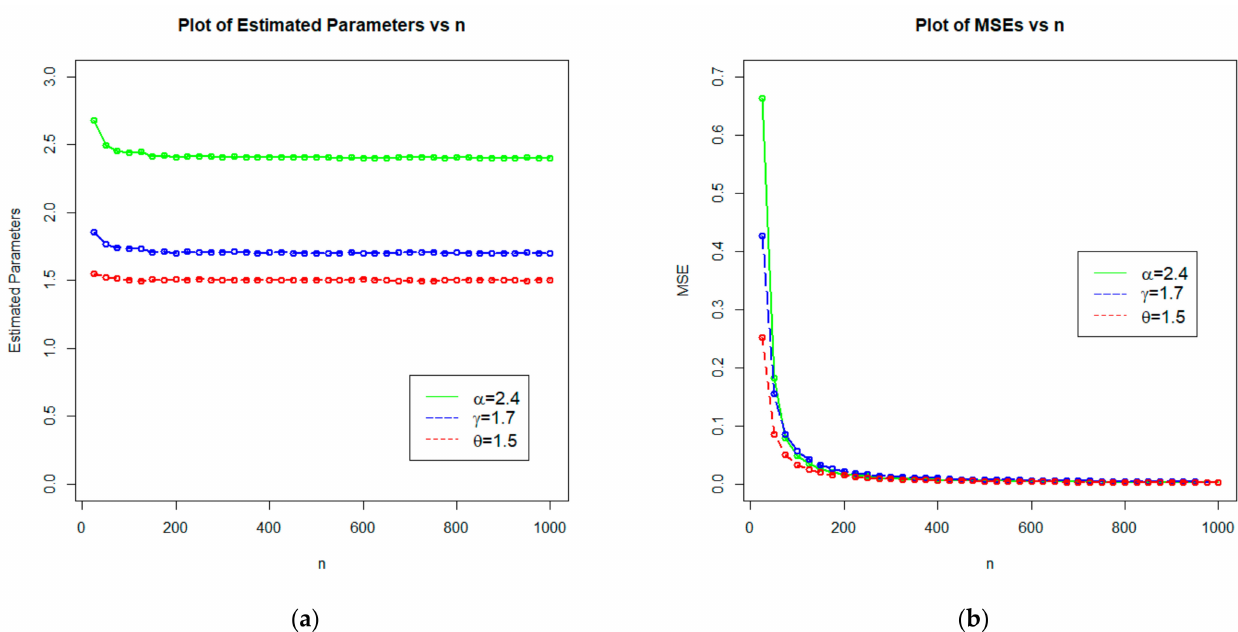
Figure 7. Plots of ( a ) estimated parameters vs. n, and ( b ) MSEs vs. n for Set 2: α = 2.4, γ = 1.7, θ = 1.5.